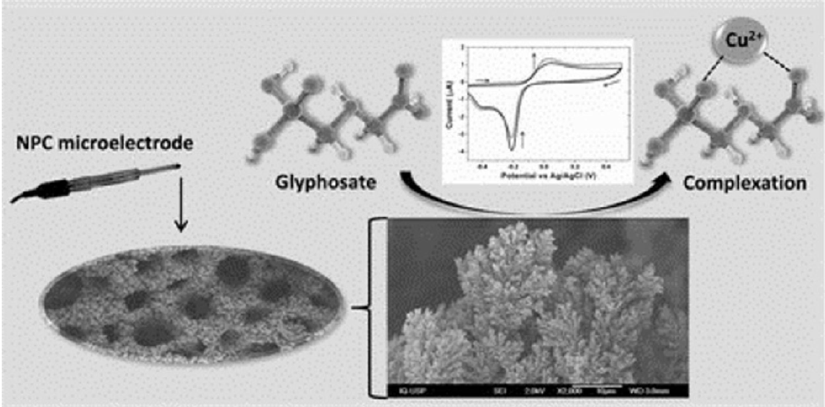
Figure 22. An electrochemically synthesized nanoporous copper microsensor for highly sensitive and selective determination of GLYP. Reprinted with permission from [111]. Copyright 2020 Wiley Online Library.